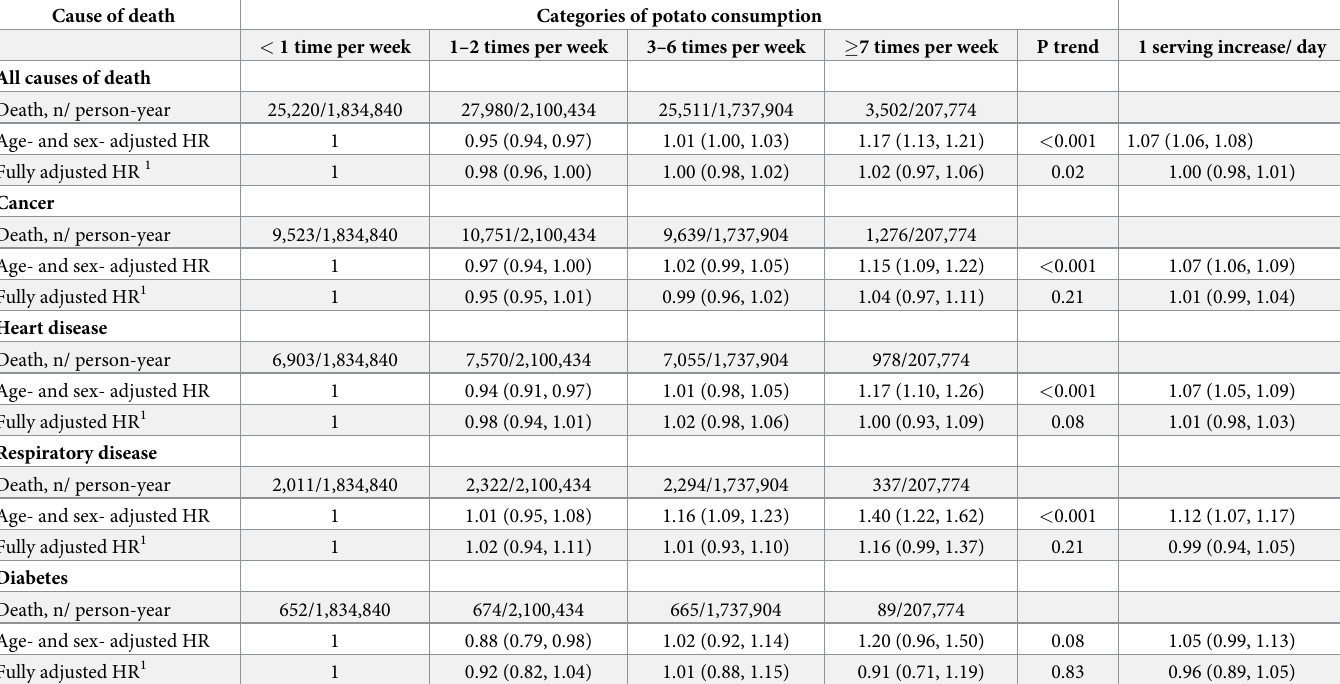
Table 2. Age and sex adjusted and fully adjusted hazard ratios for overall and cause specific mortality, for categories of total potato consumption (n =